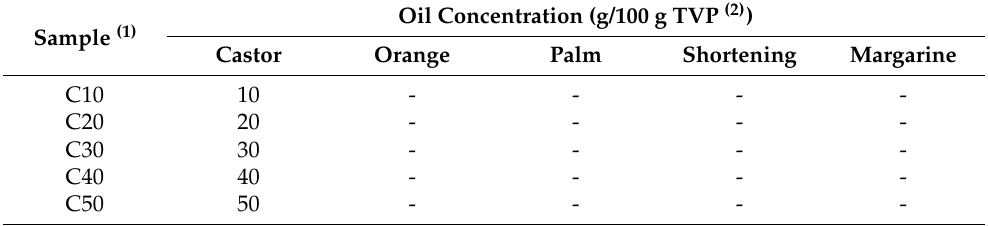
Table 1. Ingredients and contents of meat